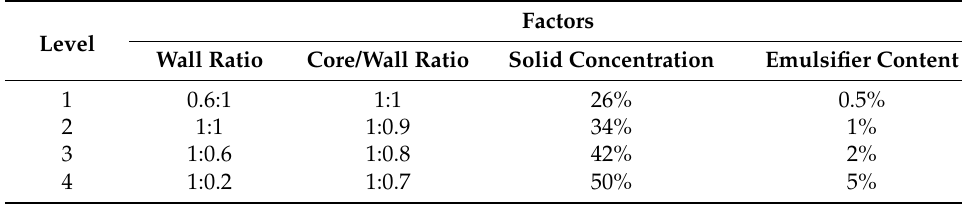
Table 1. Selected raw material factors and respective levels.